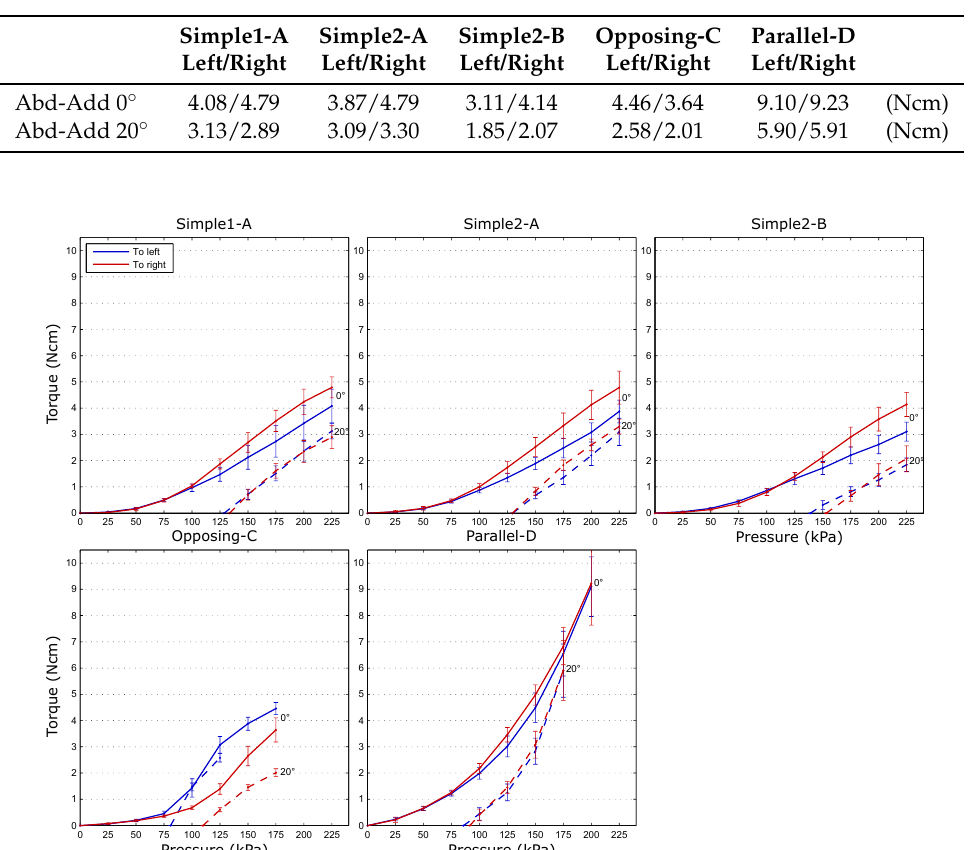
Table 4. Maximum average joint torques for abduction-adduction.